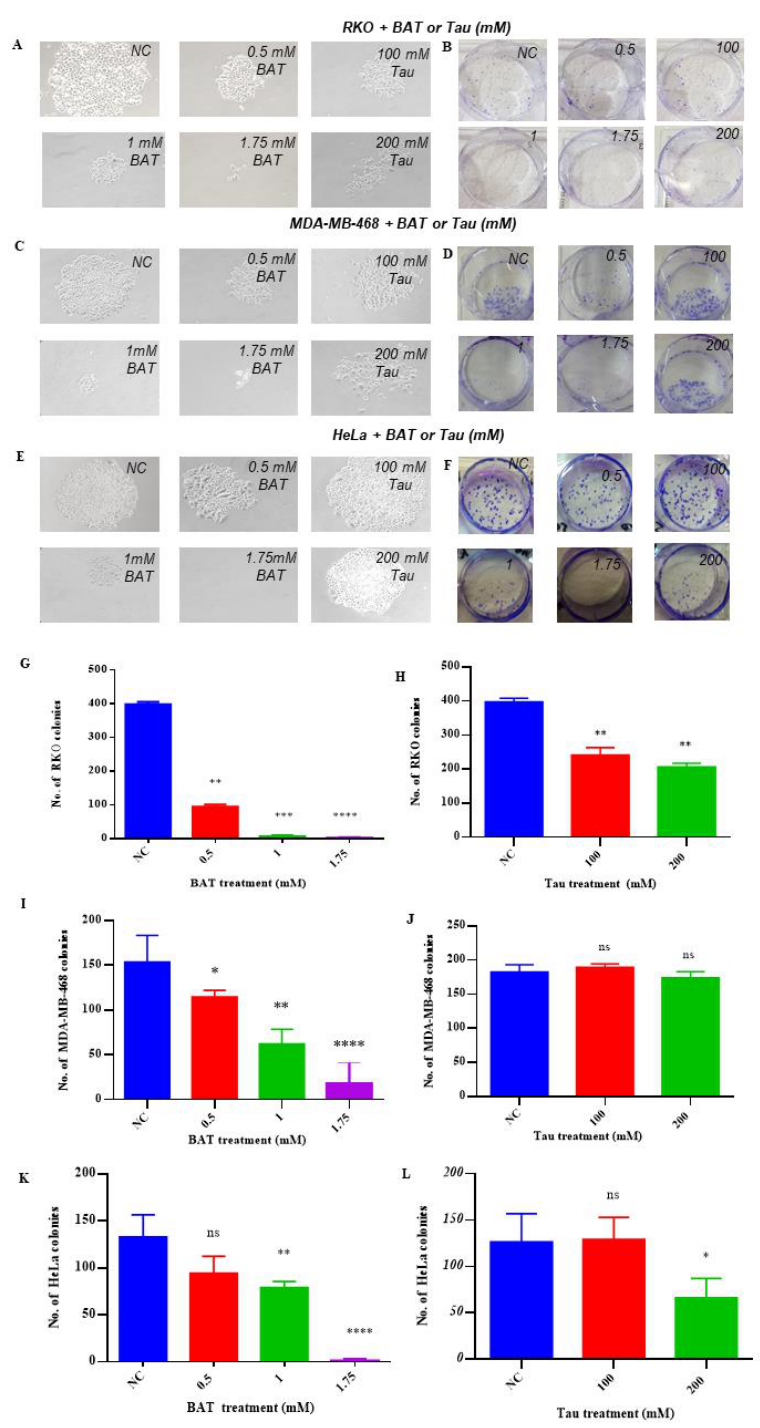
Figure 4. Both BAT and Tau seem to have a growth-inhibitory effect on the colon, breast, and cervical cancer cell growth in an anchorage-independent manner. Clonogenic growth images of ( A , B ) RKO, ( C , D ) MDA-MB-468, and ( E , F ) HeLa cells treated with (0.5–1.75 mΜ) BAT or (100–200 mM) Tau were taken after 9 days (magnification ×100). The number of colonies that occupied the area of the plate was measured, using the Promega Cell counter software. Graphs ( G , I , K ) and ( H , J , L ) represent the quantitative and statistical analysis of colony formation assays, following BAT and Tau treatment versus the negative control (NC), respectively. Ns: not significant, * p < 0.05. ** p < 0.01. *** p < 0.001. **** p < 0.0001.